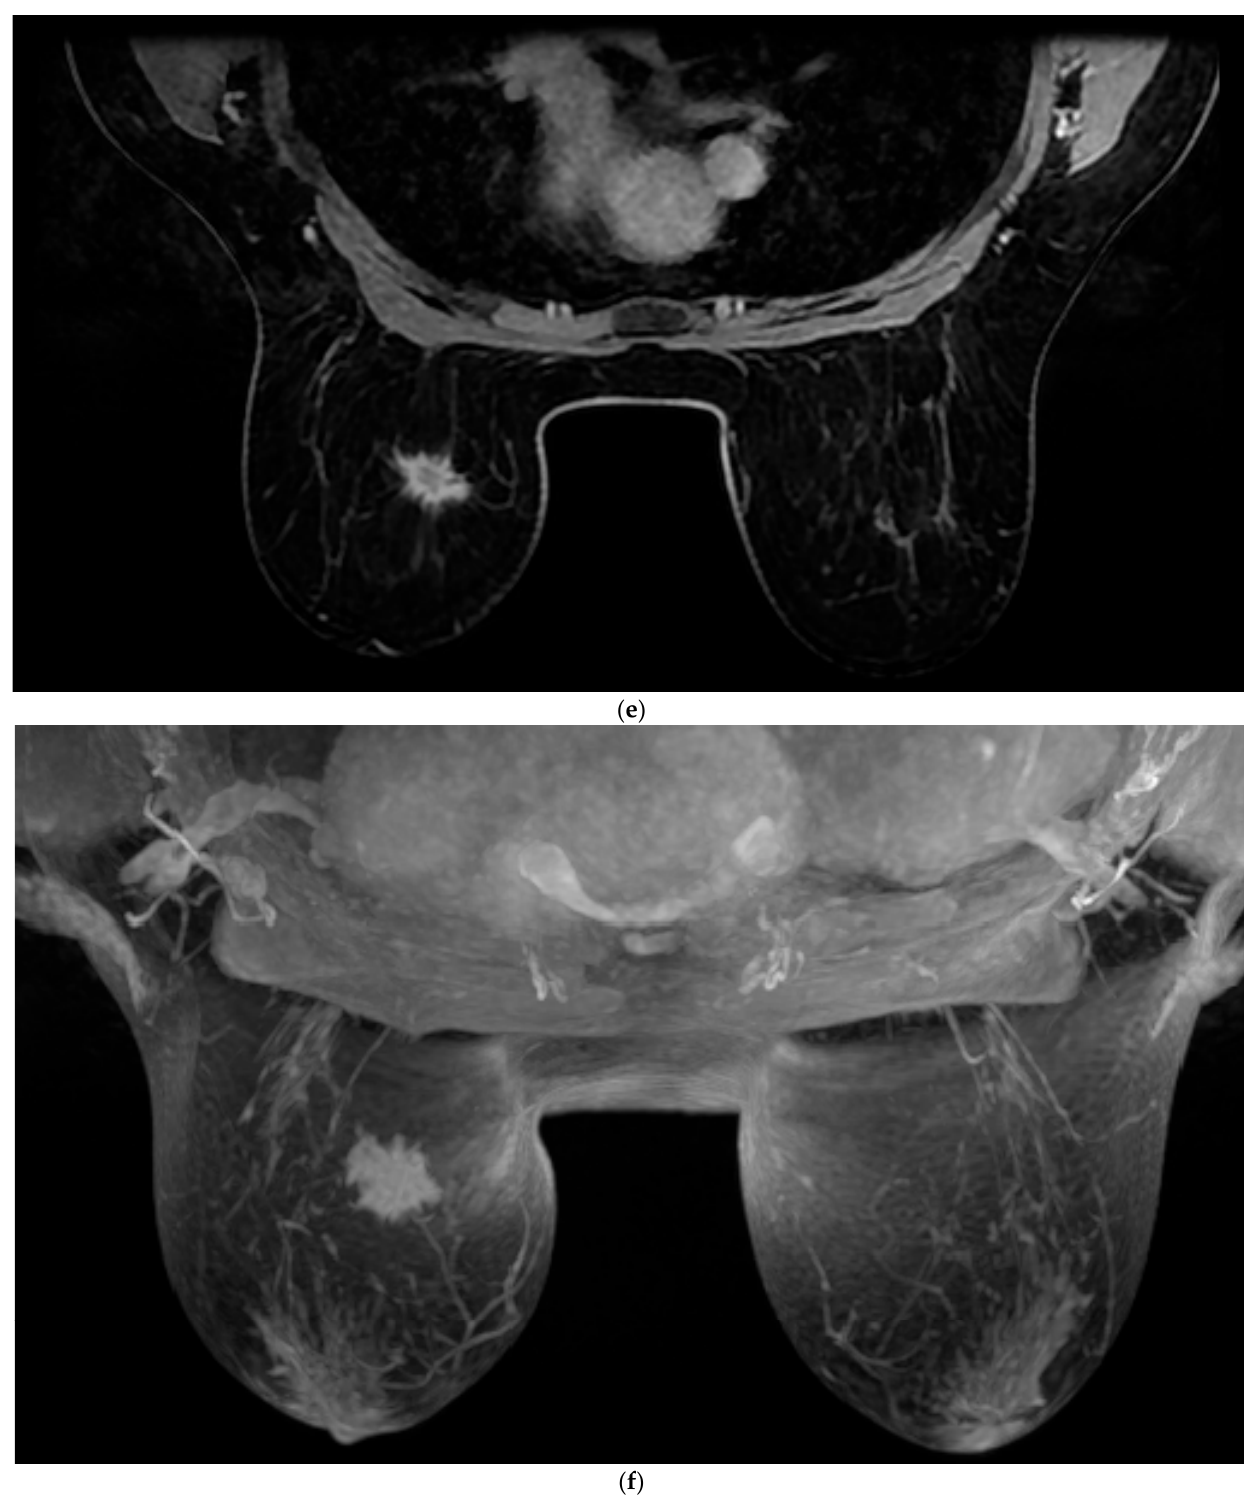
Figure 1. Images of a 43-year-old woman with a new 2 cm left breast mass (invasive ductal carci- noma—IDC). ( a ) Native. ( b ) First postcontrast sequence. ( c ) Second postcontrast sequence. ( d ) Third postcontrast sequence. ( e ) Fourth postcontrast sequence. ( f ) Maximum intensity projection (MIP).